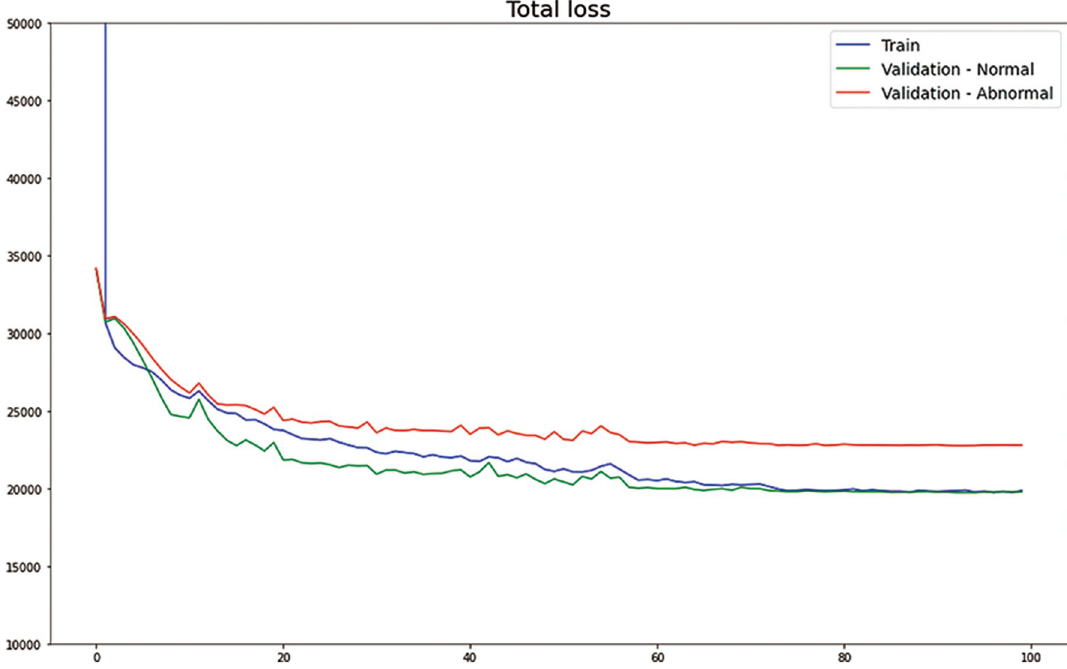
Figure 2. Total losses according to training epoch. Blue line: normal training dataset, green line: normal validation CT dataset, red line: abnormal validation CT dataset. No validation data were used during model